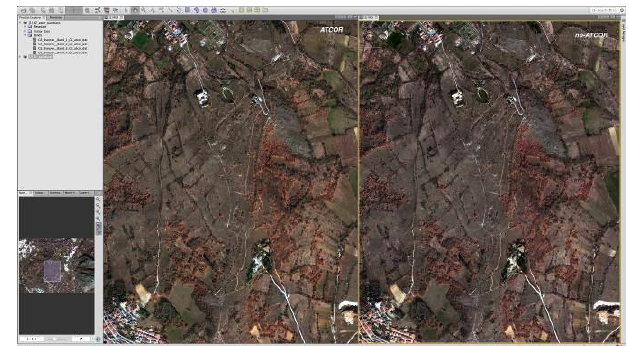
Figure 3. GeoEye raw image (left) and after ATCOR processing (right), 0.50 m resolution.